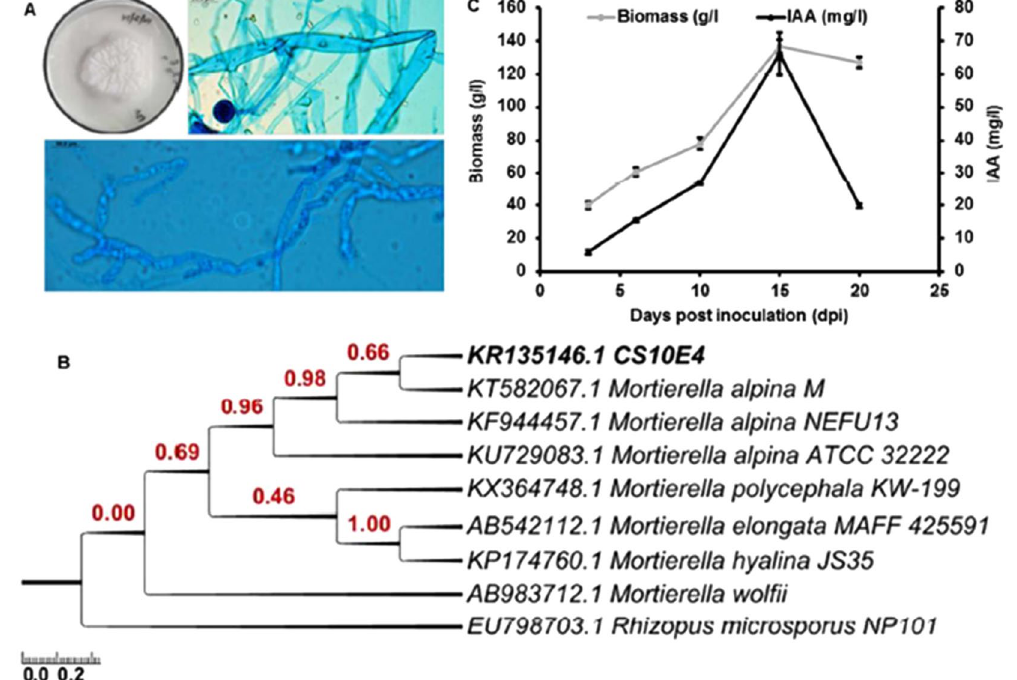
Figure 1. Morphology, molecular phylogeny and plant growth promoting property of the endophyte CS10E4 isolated from Crocus sativus . ( A ) Whitish colonies with zonate growth pattern on PDA plate. The mycelia are ceonocytic from which arise erect sporangiophores bearing terminal globose saporangia ( B ) the evolutionary history based on ITS1-5.8S-ITS2 ribosomal gene sequence was inferred by using the Maximum Likelihood method based on the Tamura-Nei model 30 . The tree is drawn to scale, with branch lengths measured in the number of substitutions per site. The analysis involved 9 nucleotide sequences and ( C ) time course accumulation of biomass and phytohormone (indole acetic acid) produced by the endophyte over a period of three weeks.